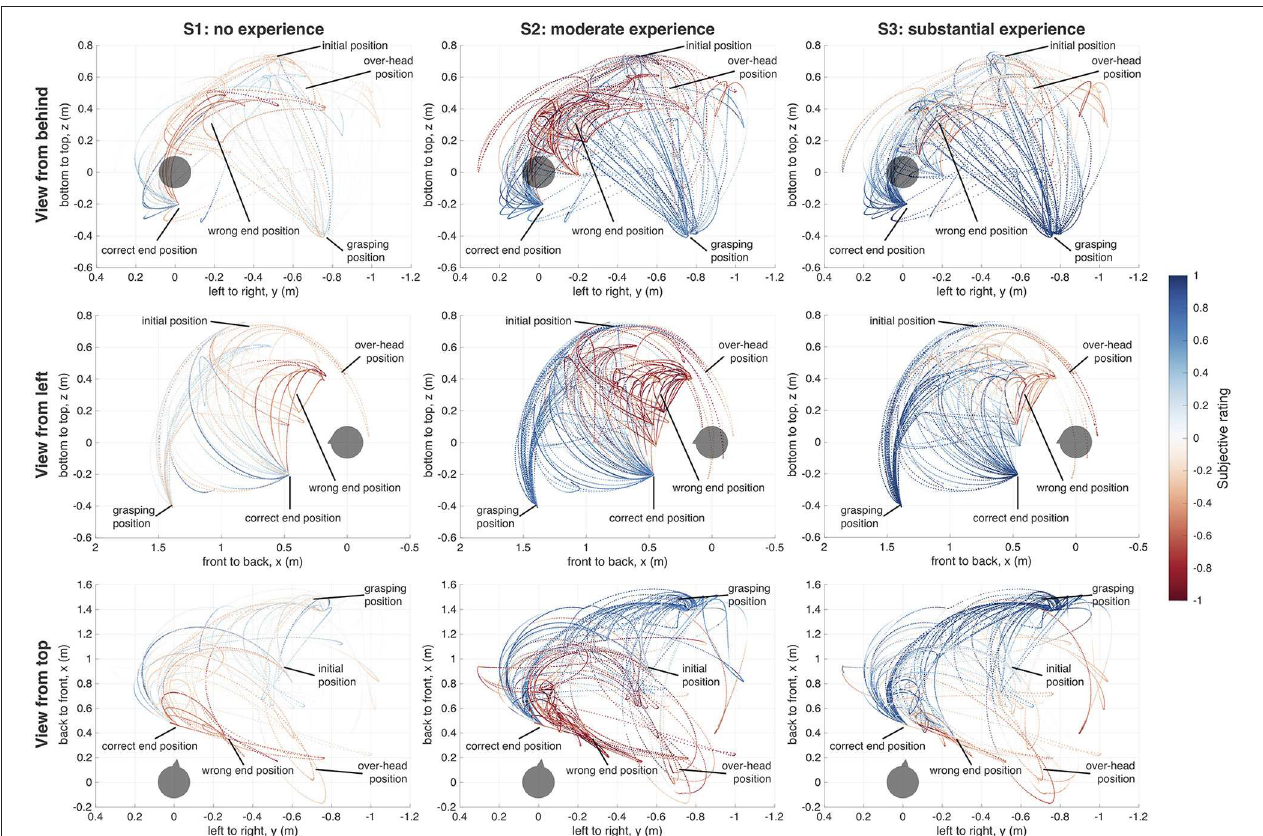
FIGURE 3 | Effector trajectories and ratings. Users with no previous robot experience (S1), moderate robot experience (S2), and substantial robot experience (S3). The positions of the points correspond to the position of the base of the robotic hand. The color of each point displays the user’s rating of the robot’s behavior at this point in time. Red color indicates a negative rating, blue color indicated a positive rating; white corresponds with a neutral rating. The axes show the distance of the robotic hand from the user’s head (gray sphere, triangle represents user’s nose) in meters within the respective dimension (x, y, z).